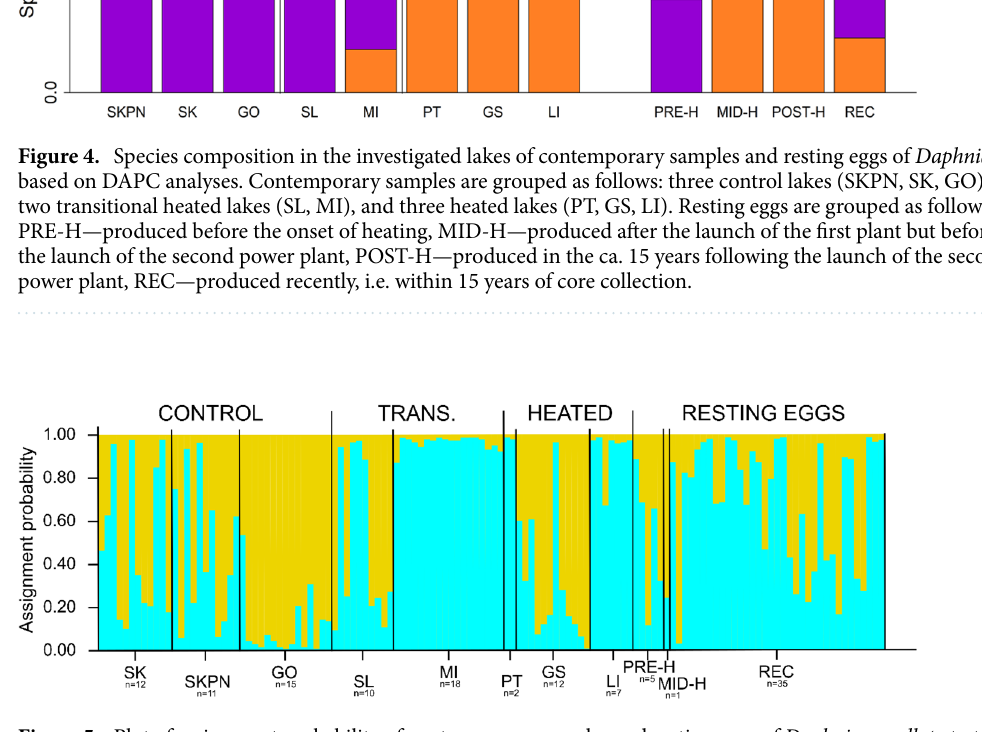
Figure 5. Plot of assignment probability of contemporary samples and resting eggs of Daphnia cucullata to two genetically distinct clusters (different colours), inferred with STRU CTU RE. Each vertical line represents the assignment probability of one individual to two inferred clusters (light blue or yellow). Contemporary samples are grouped as follows: three control lakes (SK, SKPN, GO), two transitional (TRANS.) heated lakes (SL, MI), and three heated lakes (PT, GS, LI). Resting eggs are grouped as follows: PRE-H—produced before the onset of heating, MID-H—produced after the launch of the first plant but before the launch of the second power plant,